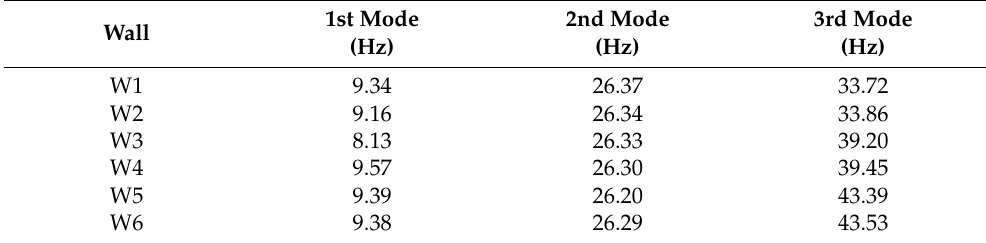
Figure 9. Example of the mode shapes for wall W1: ( a ) f1 = 9.34 Hz; ( b ) f2 = 26.37 Hz; and ( c ) f3 = 33.72 Hz. Table 3. Wall frequencies obtained experimentally.